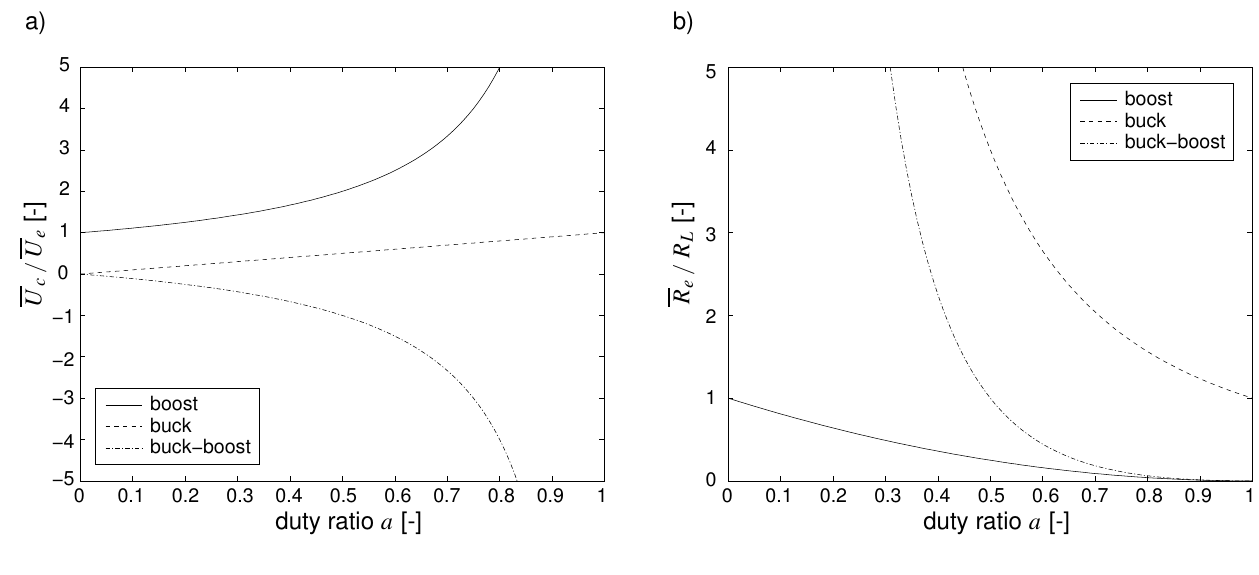
Figure 6. Stationary and averaged output voltages U boost, buck and buck-boost converters with respect to their duty ratio a